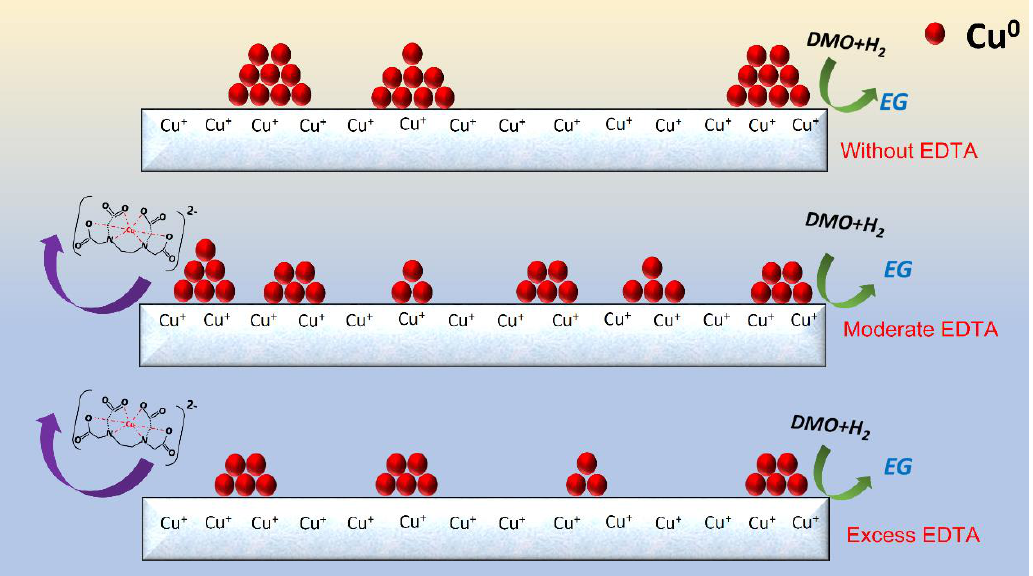
Figure 9. The evolution of the structure – performance relationship caused by the introduction of EDTA.